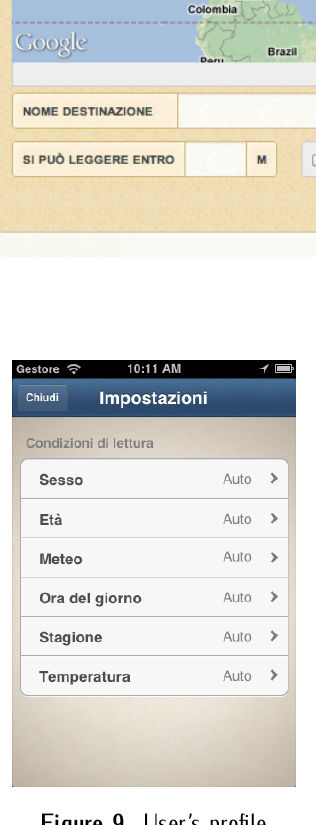
Figure 9. User’s profile Figure 10. Reader’s